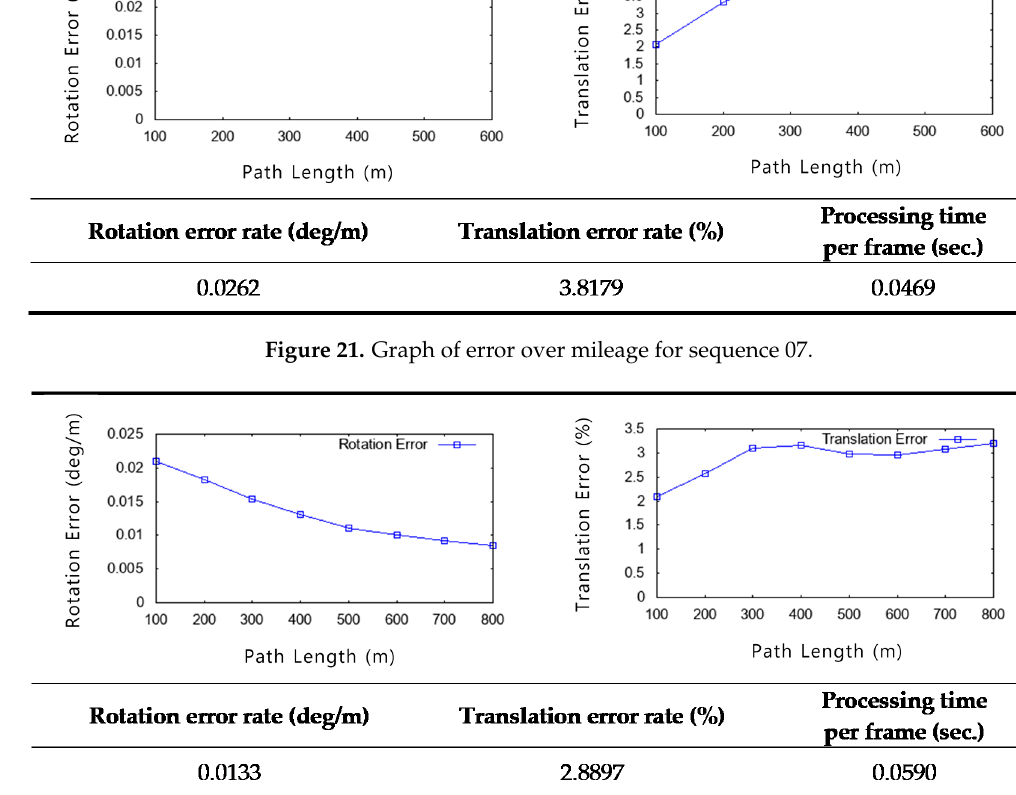
Figure 22. Graph of error over mileage for sequence 08.